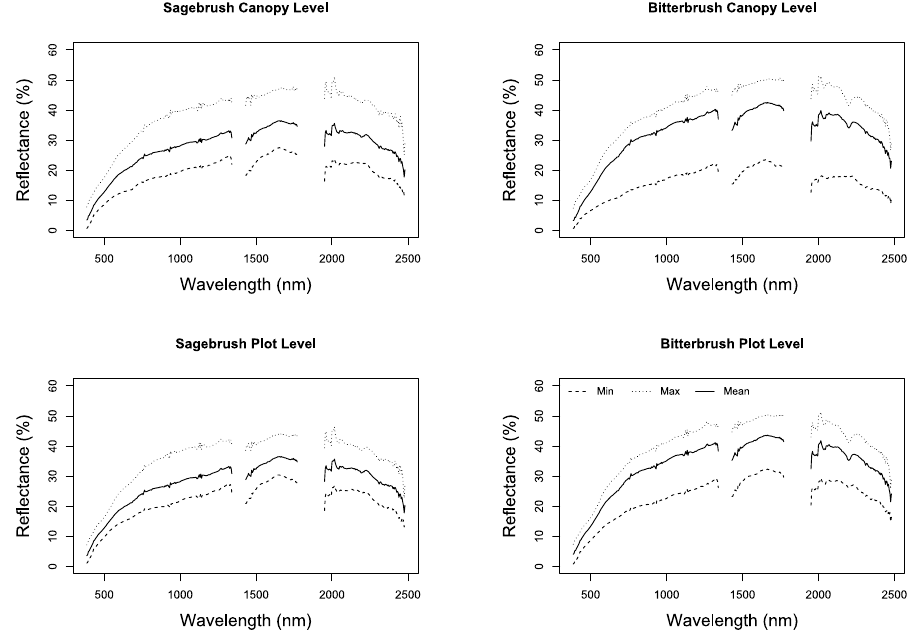
Figure 2. The mean, minimum and maximum reflectance spectra of sagebrush and bitterbrush at canopy level and 10 × 10 m plots of two species.